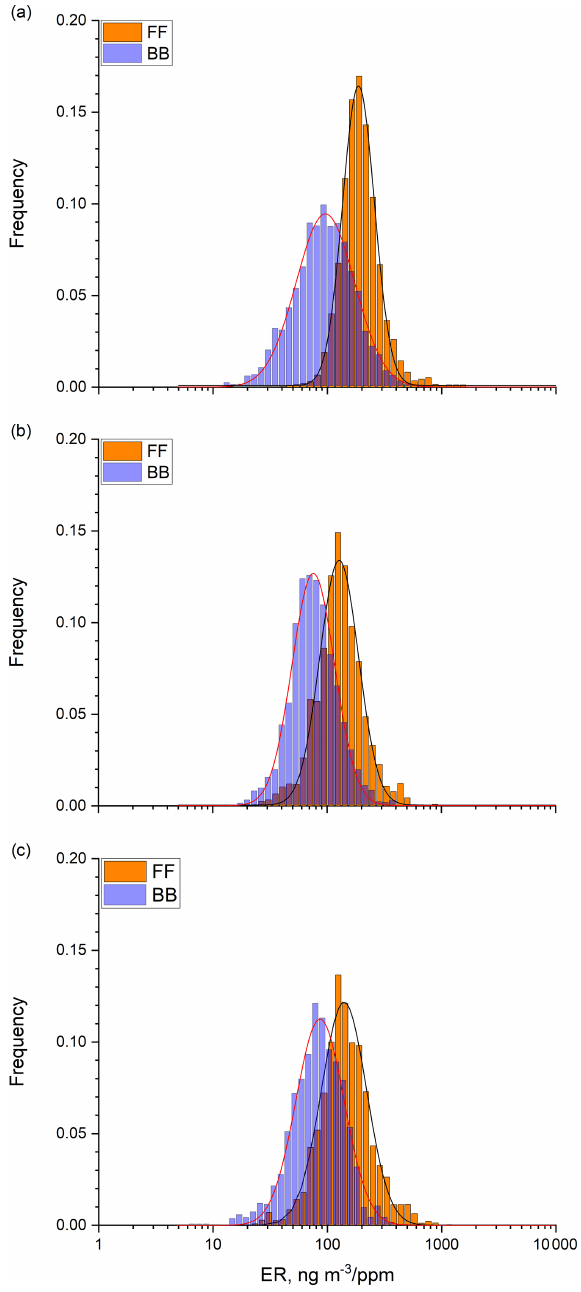
Figure 5. FF-related (orange) and BB-related (blue) ERs at (a) BTC, (b) SKY, and (c) TRO locations, respectively. The dis- tributions are normalized to 1. Lognormal distributions (solid lines) were fitted to the results: the parameters are summarized in Table 3.